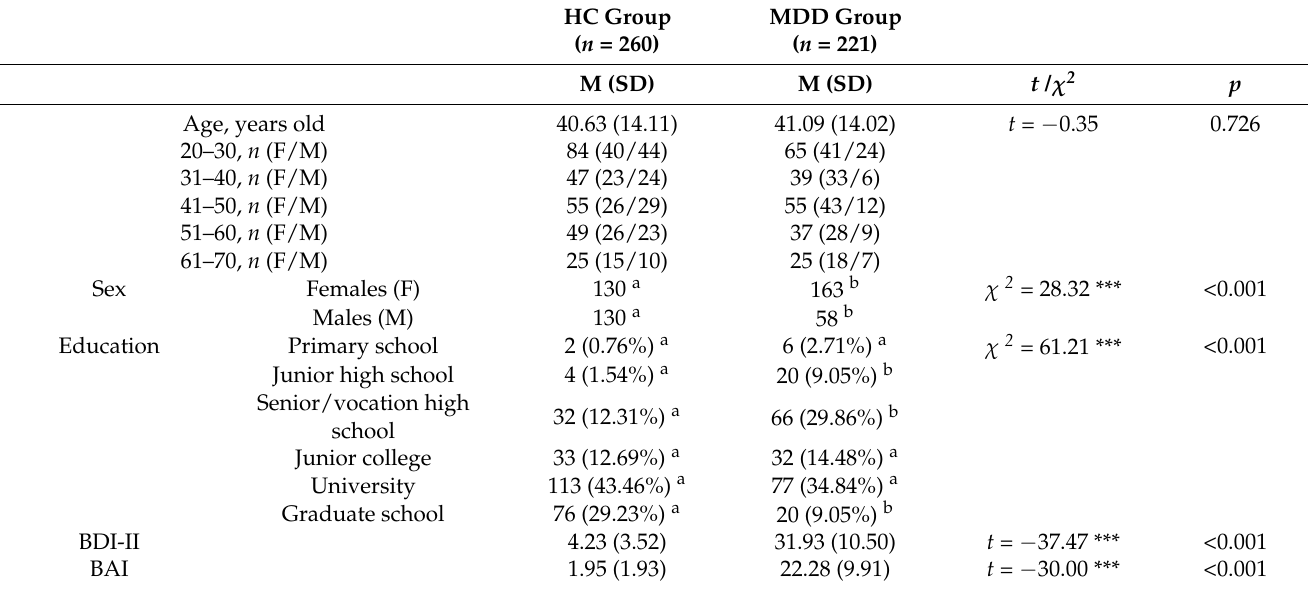
Table 2. The demographic characteristic between the HC group and MDD